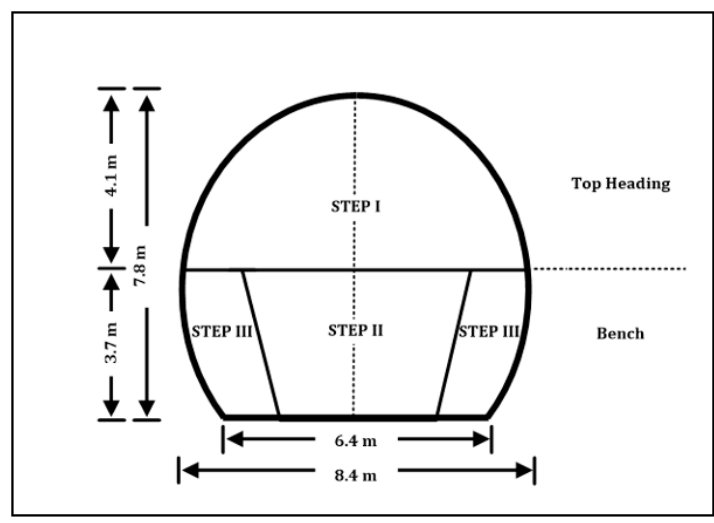
Figure 2. Dimensions of the tunnel and its excavation sequence.